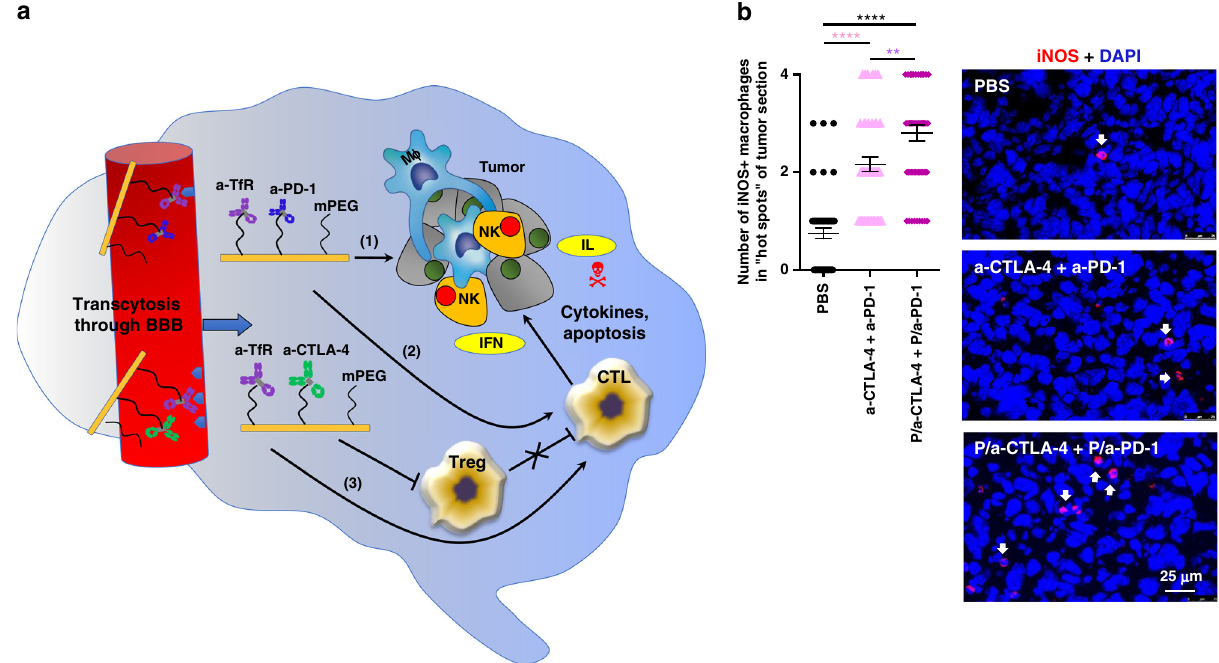
Fig. 6 Proposed mechanism of local brain immune activation by NIC treatment. a The proposed mechanism of synergistic treatment with a-CTLA-4 and a- PD-1 mAbs when they cross BBB as part of a nano immunodrug. (1) a-PD-1 initiates central pathway inhibition with cancer cell attack; (2) a-PD-1 activates cytotoxic T lymphocytes; and (3) a-CTLA-4 provides local inhibition of Treg. In addition, activated macrophages (M Φ ) and NK cells also contribute to tumor cell elimination. IL interleukin; IFN interferon. b Ex vivo study of M1 M Φ by immunostaining for iNOS (arrows) demonstrates their increased numbers in the brain tumors after combined NIC treatment as compared to PBS or a combination of free antibodies. Data are mean ± SEM. ** p < 0.01; **** p < 0.0001 (ANOVA with Sidak ’ s